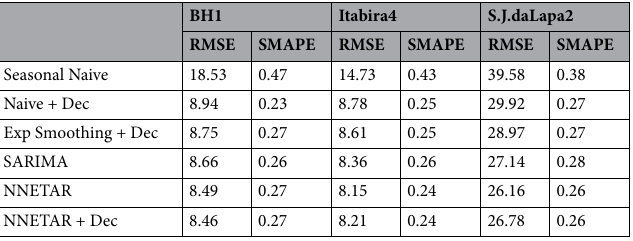
Table 1. Accuracy measures (RMSE and SMAPE) for the model fit of each of the five considered models, in the data from the three monitoring stations, BH1, Itabira4, and S.J.daLapa2.